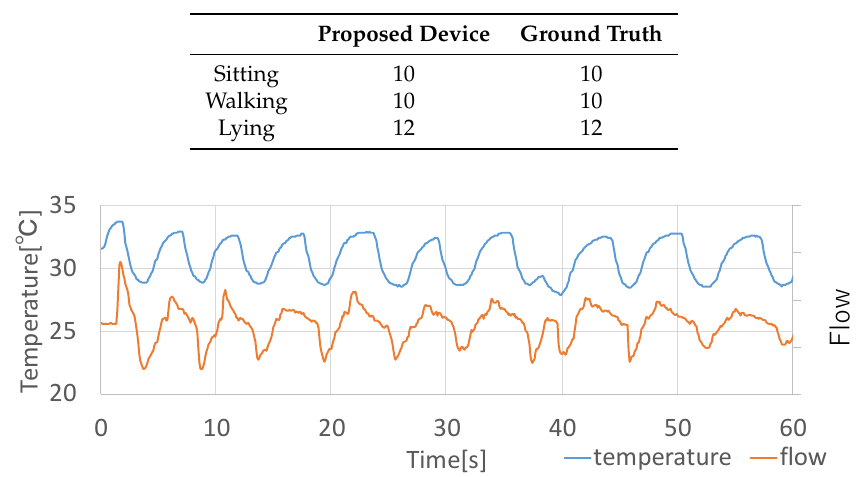
Figure 7. Results of airflow and